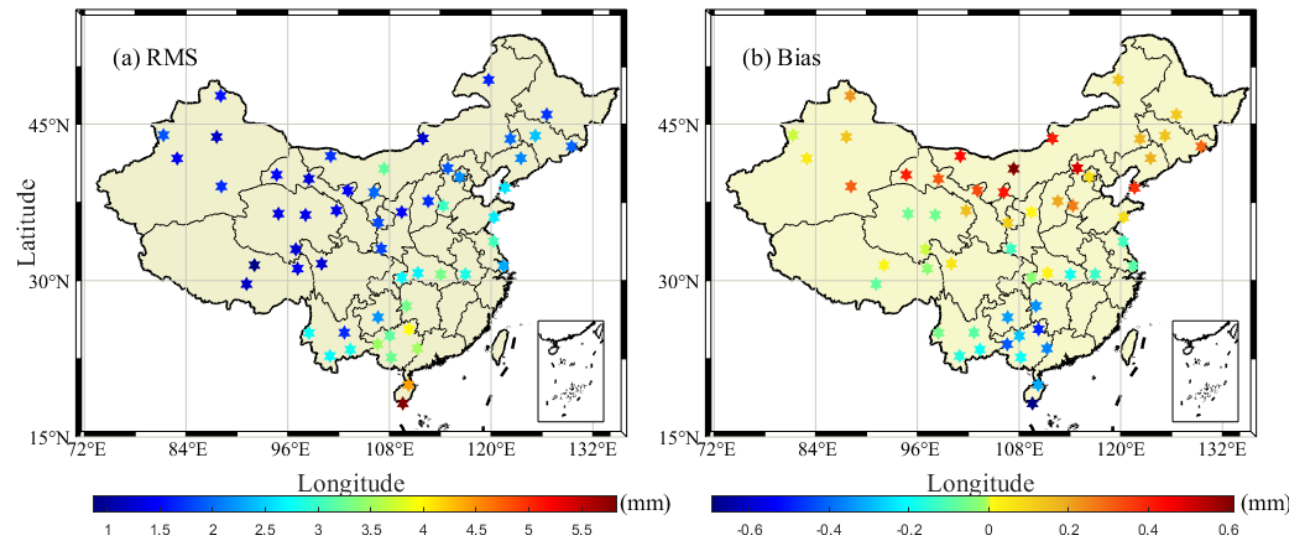
Figure 4. RMS and Bias distributions of PWV differences between GNSS and RS over the period of 2012 to 2020.